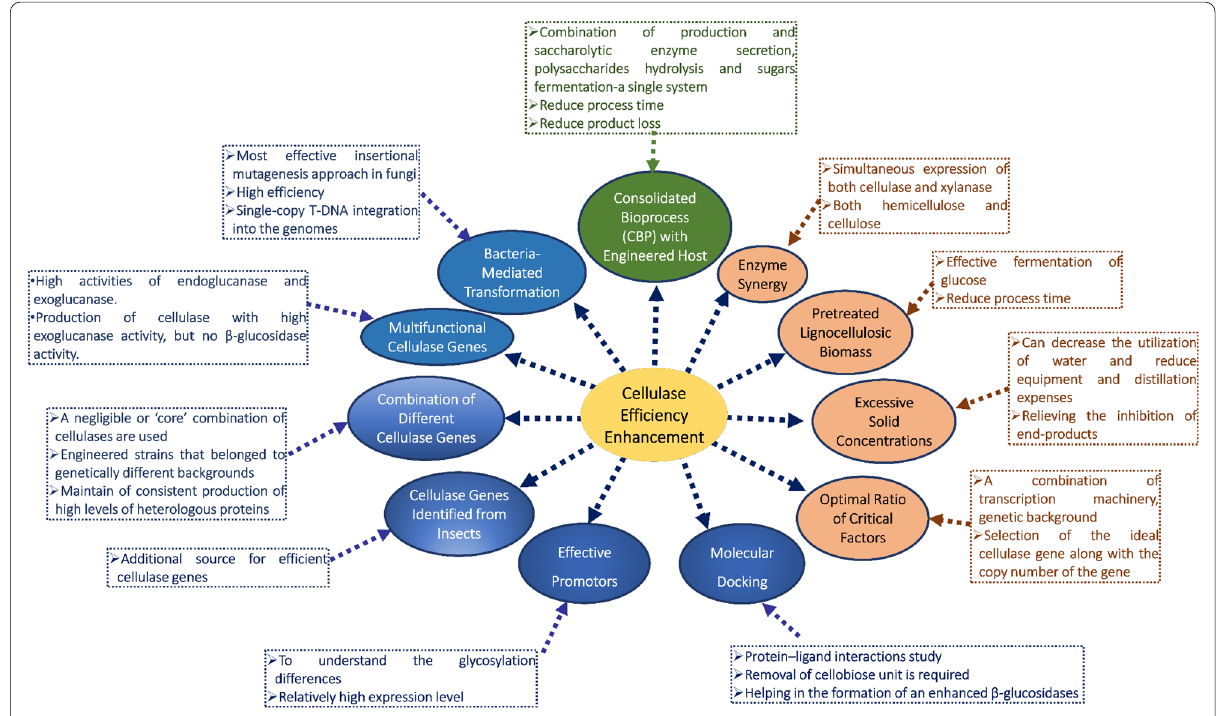
Fig. 3 Strategies to increase cellulase efficiency and